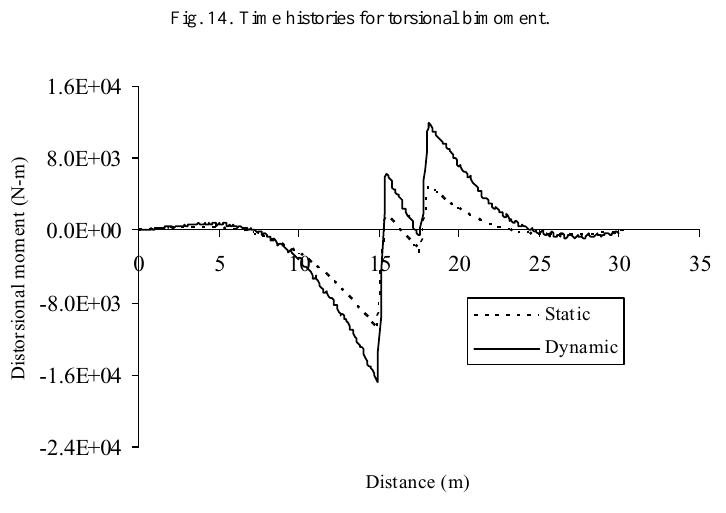
Fig. 14. Time histories for torsional bimoment.